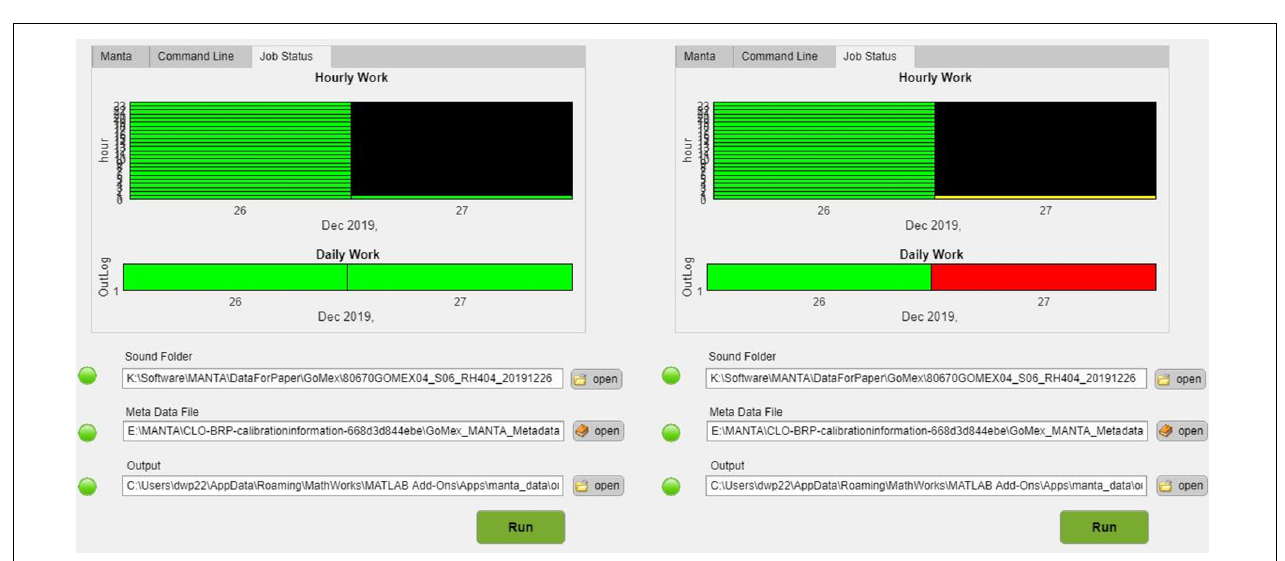
FIGURE 5 | MANTA output image of daily spectral probability density plot with percentiles from January 1, 2020. This data was collected by Cornell University in the northern Gulf of Mexico. Funding for this project was provided by the U.S. Department of the Interior, Bureau of Ocean Energy Management, Environmental Studies Program, Washington, DC, United States, under Contract Task Order Number M17PC00001_17PD00011 (contract managed by HDR, Inc).